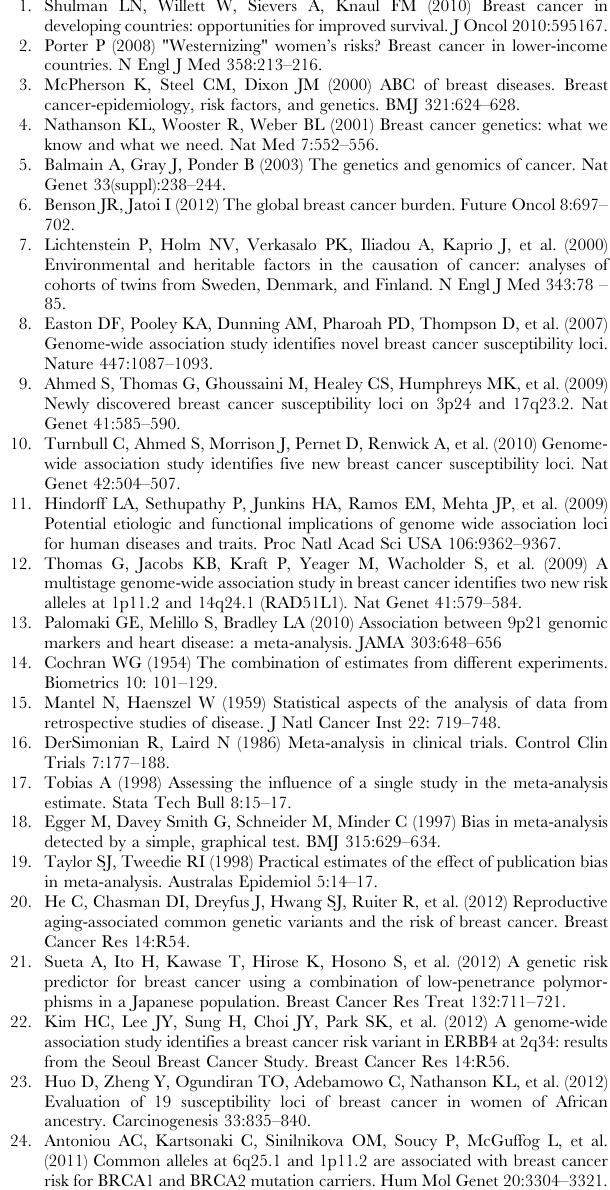
Figure S1 Flow chart of literature search for studies examining 1p11-rs11249433 polymorphism and risk of BC.